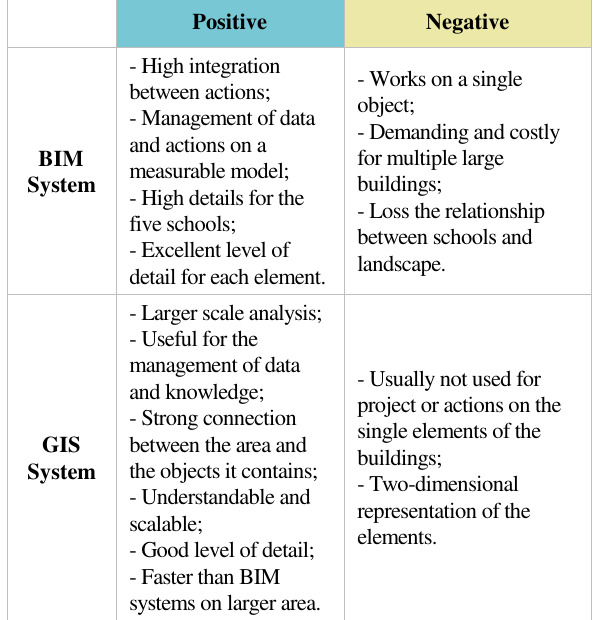
Table 1. Positive and negative aspects of GIS and BIM systems for the National Art School’s CMP